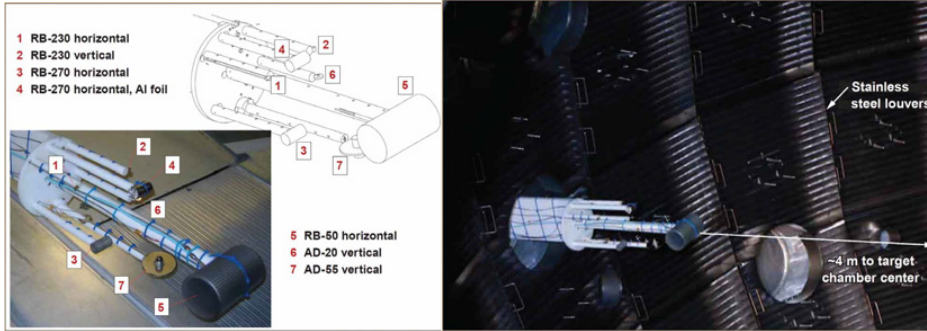
Figure 1. Target chamber